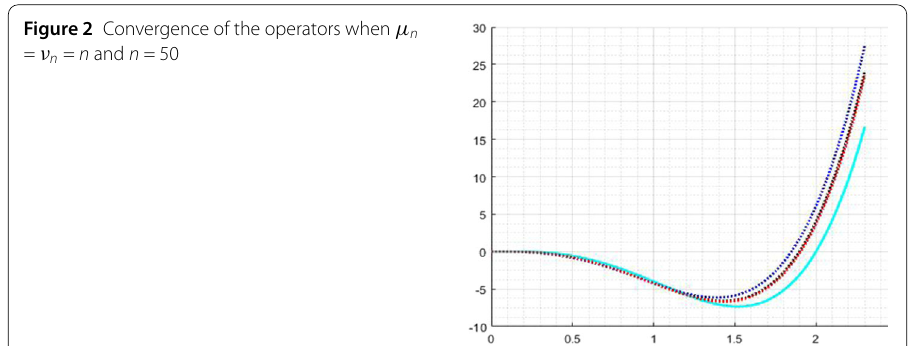
Figure 2 Convergence of the operators when μ n = ν n = n and n = 50